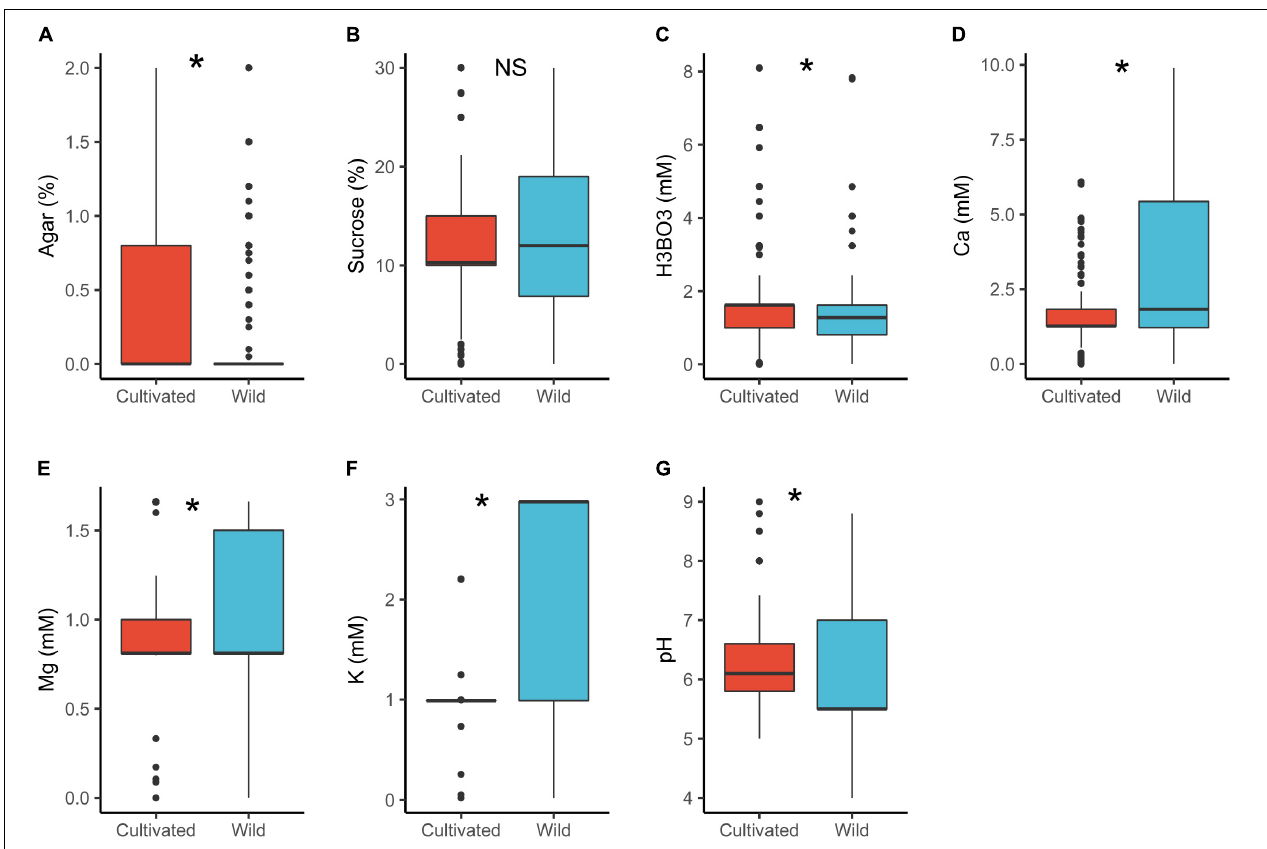
FIGURE 1 | Pollen germination media requirements for cultivated ( n = 449) and wild species ( n = 689): agar (A) , sucrose (B) , boric acid (C) , calcium (D) , magnesium (E) , potassium (F) , and pH (G) . *, significant ( p < 0.05); NS, not